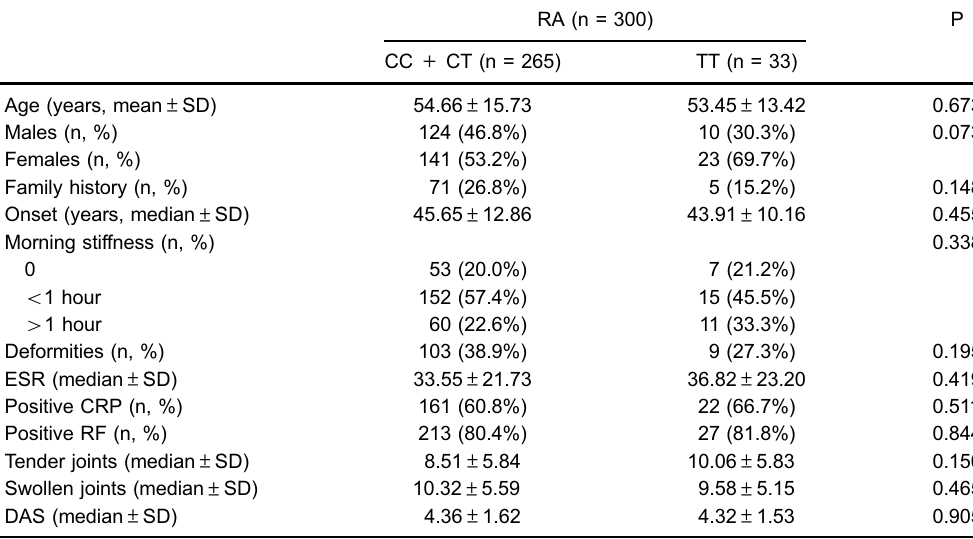
Table 5. Comparison of studied data according to autoimmune regulator (AIRE) genotypes in all rheumatoid arthritis (RA) cases.